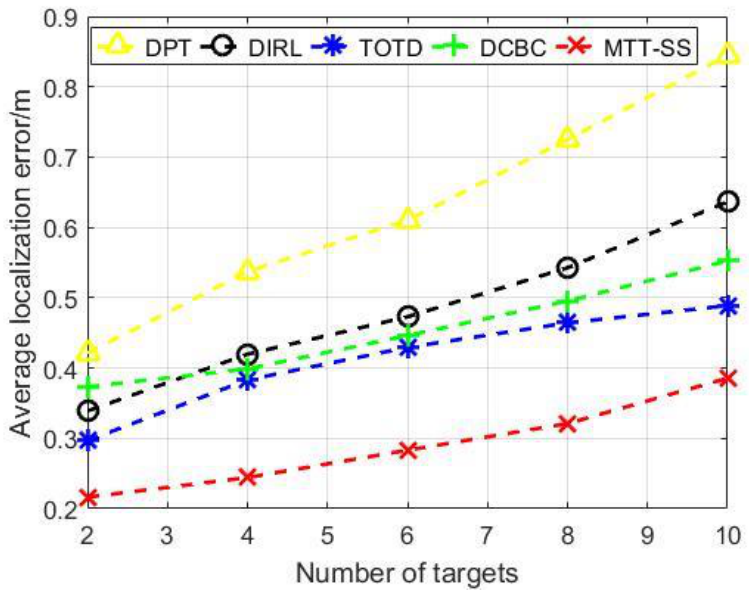
Figure 6. Average localization error vs. number of targets.